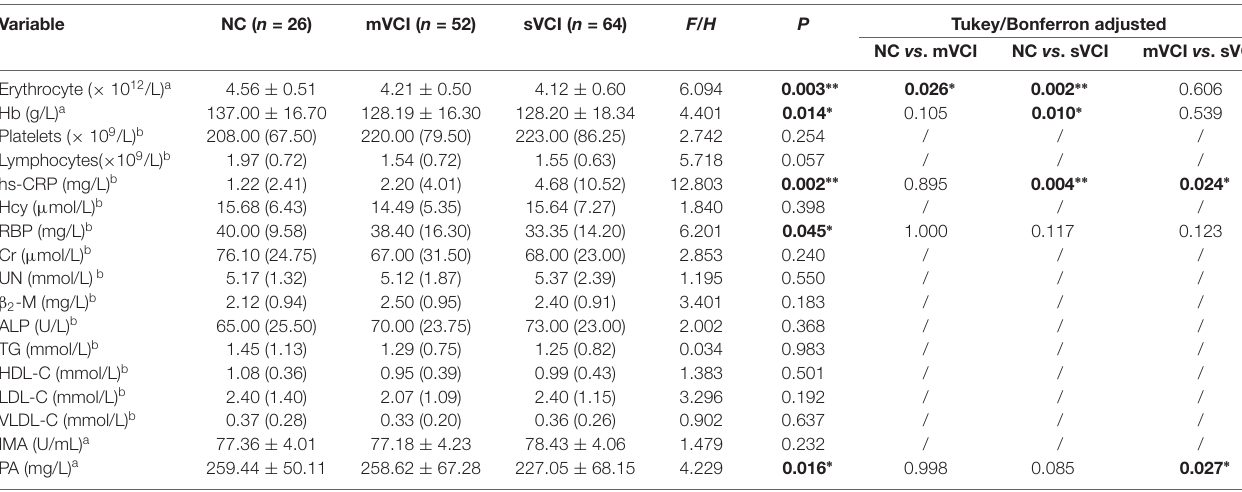
TABLE 3 | Comparison of various biomarkers of different cognitive levels in the sWMH group.